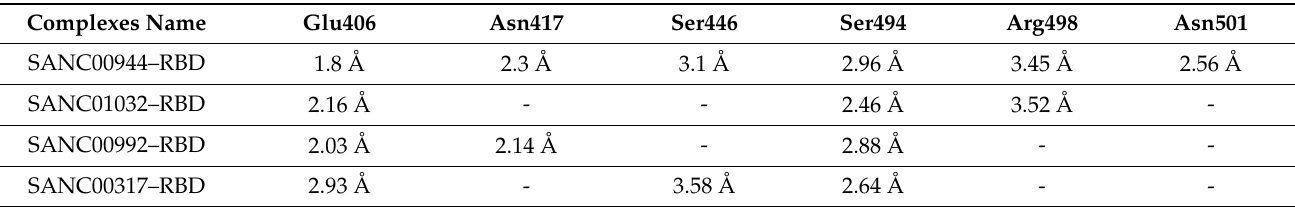
Figure 10. Hydrogen bonding analysis of the SANC01032–RBD, SANC01032–RBD, SANC00992–RBD, and SANC00317–RBD complexes. Table 2. Distances of key interacting residues during the simulation.